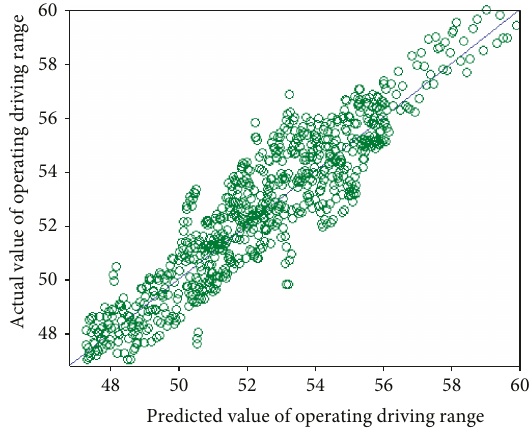
Figure 18: Scatter diagram of predicted values and actual values (operating driving range, km).